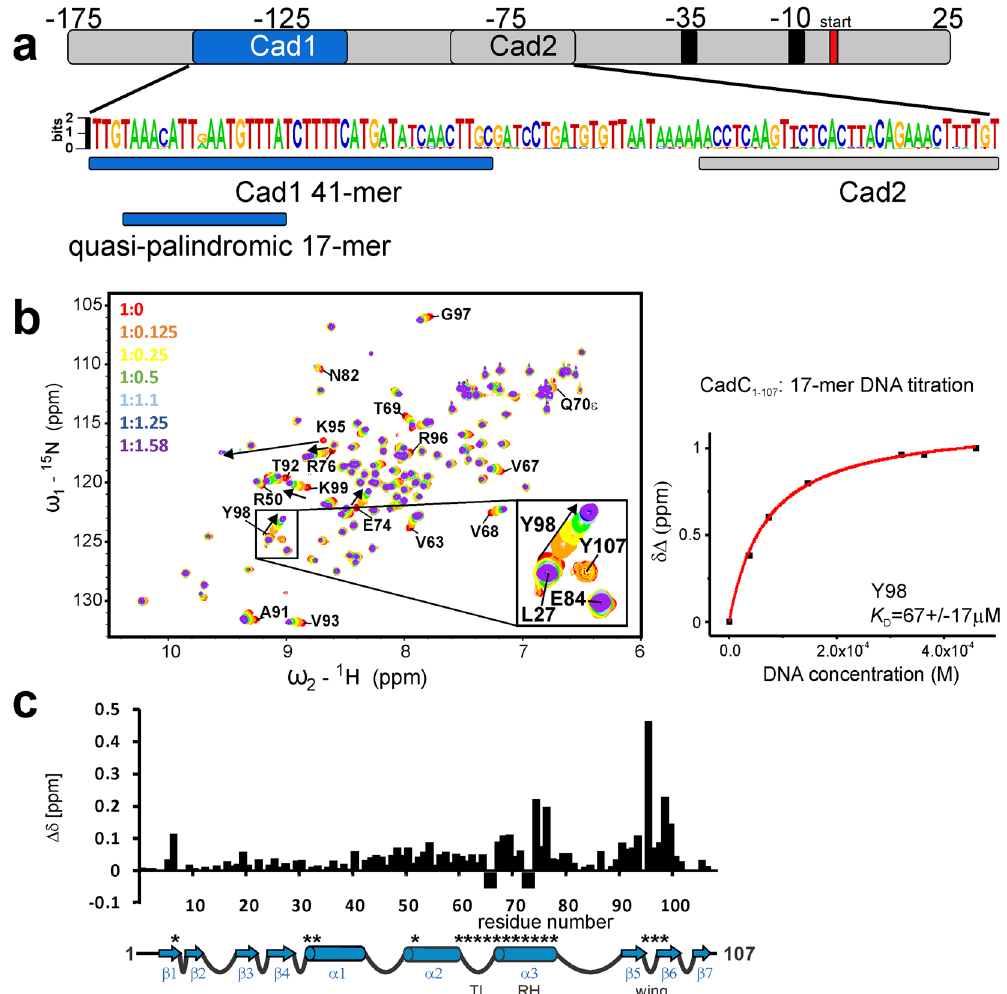
Figure 4. NMR analysis of CadC 1-107 binding to Cad1 DNA. ( a ) Top, the scheme shows the full cadBA promoter region between − 175 bp and 25 bp relative to the transcription start with CadC binding sites Cad1 and Cad2, and the RNA polymerase binding sites at − 35 bp and − 10 bp. Middle, web-logo showing the conservation of nucleotides in the Cad1 and Cad2 fragments of the cadBA promoter region for enteric bacteria according to NCBI blastn 75 . The loci of the Cad1 and Cad2 sites are indicated. Blue bars represent the Cad1 41-mer and the quasi-palindromic 17-mer core sequences used in this study. ( b ) Left, superposition of 1 H- 15 N-HSQC spectra from CadC 1-107 in the absence or presence of different amounts of Cad1 17-mer DNA (see colour codes) with selected residues depicted. The inset shows a magnification of selected amide resonances. Right, quantification of CSPs of Tyr 98 (see inset) by fitting relative CSPs to a 1:1 binding model. The given binding constant is calculated from all significantly shifting resonances and shown as mean ± standard deviation. ( c ) Plot of CSPs, i.e. the difference of chemical shifts of free CadC and the complex with maximum DNA (1:1.58). Gaps indicate prolines; negative bars are residues in which the assignment in either the bound or apo-form is missing. The scheme at the bottom of the diagram shows the secondary structure of the CadC DBD based on the crystal structure with elements annotated. Asterisks indicate positions that were used for mutational analyses at a later stage of the study. TL, transactivation loop; RH, recognition helix; wing, β